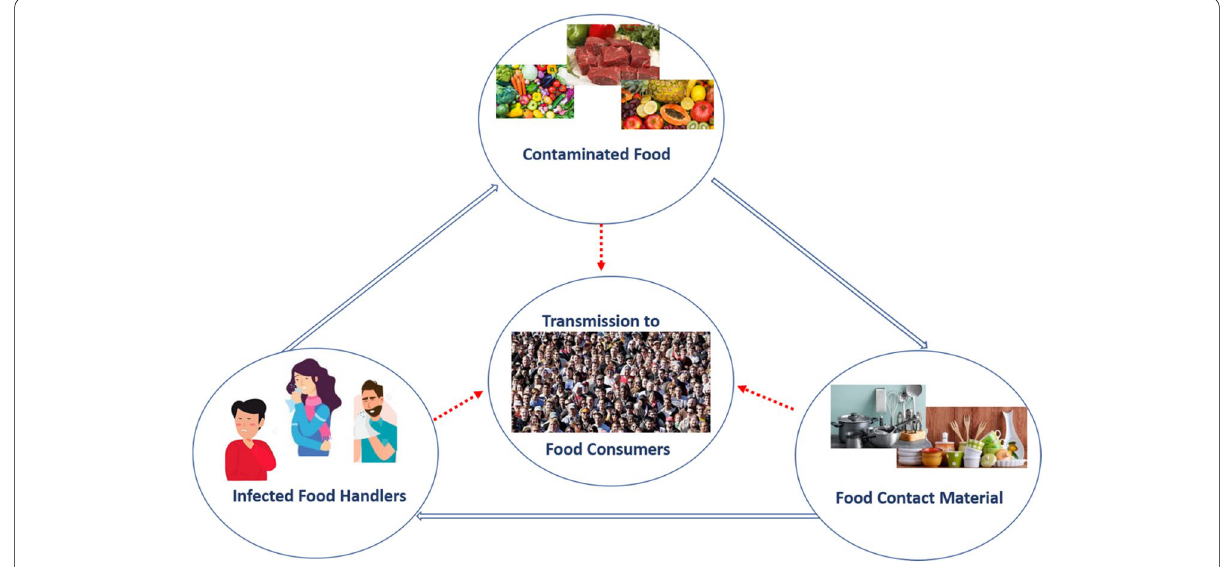
Fig. 1 The potential transmission pathway of coronaviruses via food products and processes